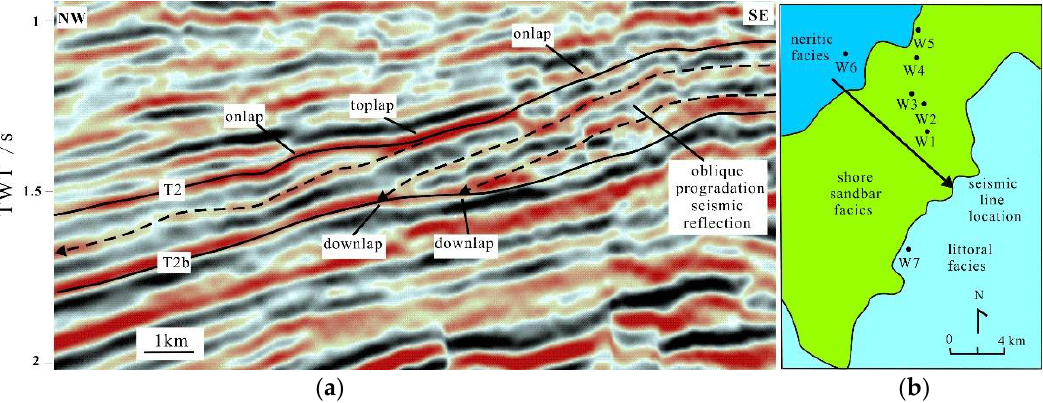
Figure 6. The oblique progradation seismic reflection characteristics of a sandbar along the prove- nance direction ( a ), sandbar sedimentary facies and seismic section location map of B member sandbar ( b ). T2: the top of B sand, T2b: the bottom of B sand. Onlap, toplap and downlap are the basic used terms for sequence stratigraphy. Through these terms, the seismic phase analysis is carried out.